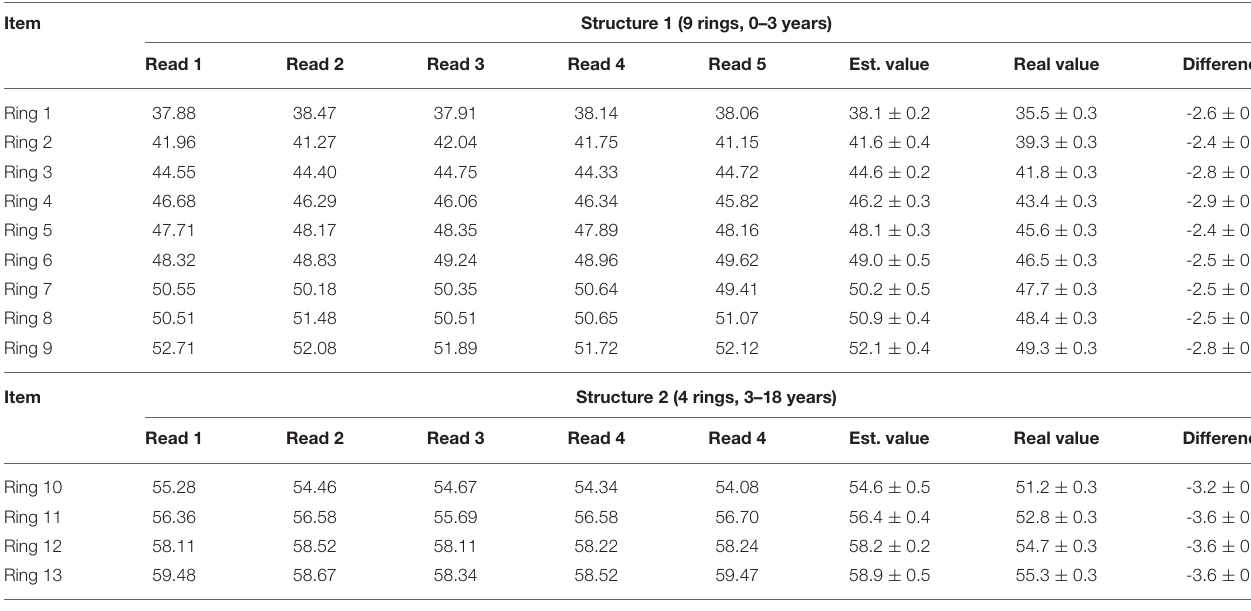
TABLE 3 | Record of the differences encountered between the automatically obtained circumferences (column Est. Value) and the physical circumferences of the rings in the phantoms (column Real Value). Item